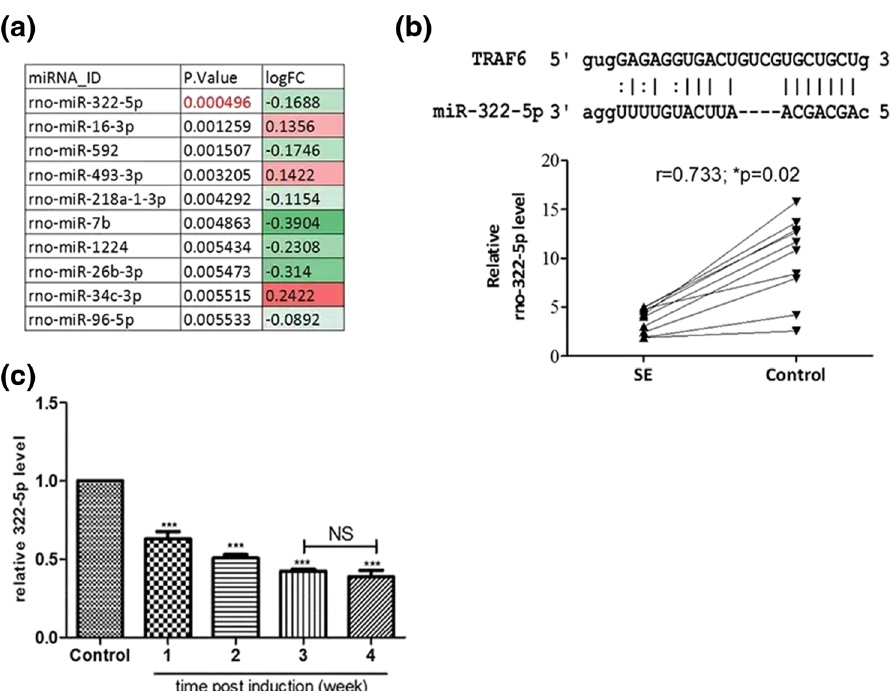
Figure 2: The expressionofmiR - 322 - 5p.Notes: ( a ) miR - 322 - 5pwasidenti fi edasoneofthemost decreasedmicroRNAspecies postSEinductioninrats ’ brain ( GSE49850 ) . ( b ) Insert demonstrates the binding sequences of miR - 322 - 5p and the 3 ′ - UTR of TRAF6. Lower the panel, a relatively strong negative correlation was identi fi ed between the expression of miR - 322 - 5p and TRAF6 mRNA in patients with intractable epilepsy. ( c ) Real - time PCR analysis of mRNA isolated from SE rat brains indicated a signi fi cantly decreased miR - 322 - 5p in the SE rats post induction. *** p < 0.001 compared with